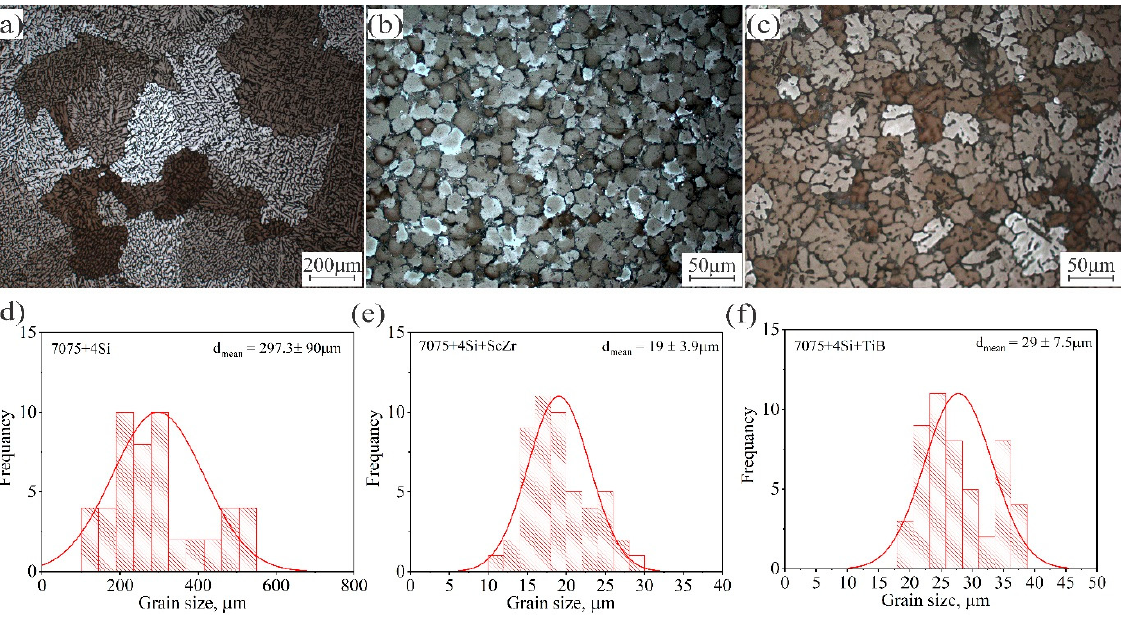
Figure 2. Optical micrographs and grains statistical of the as-casted alloys; ( a, d ) 7075 - 4%Si, ( b, e ) 7075 - 4%Si + ScZr, and ( c, f ) 7075 - 4%Si + TiB.